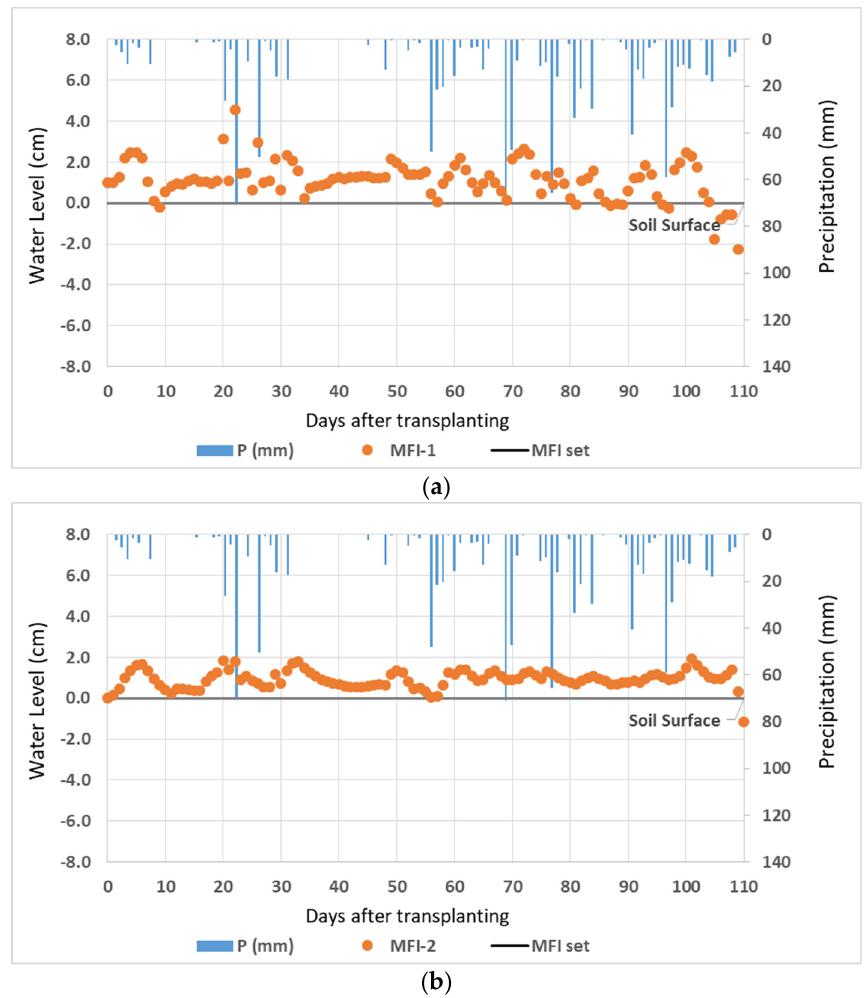
Figure 6. The actual field condition of water levels: ( a ) MFI-1; ( b ) MFI-2.